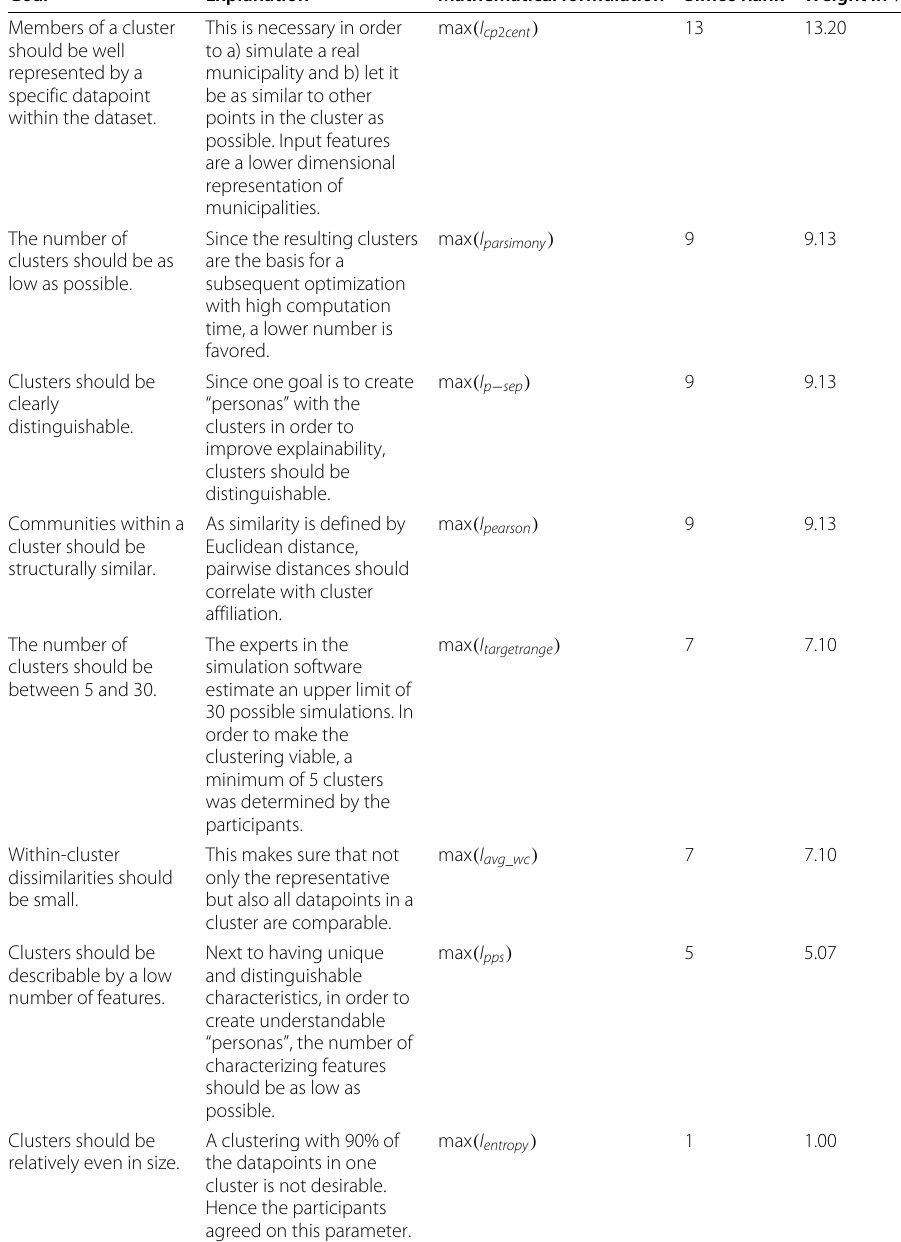
Table 5 Clustering goals and decision rules for municipalities Goal Explanation Mathematical formulation Simos Rank Weight in % Members of a cluster should be